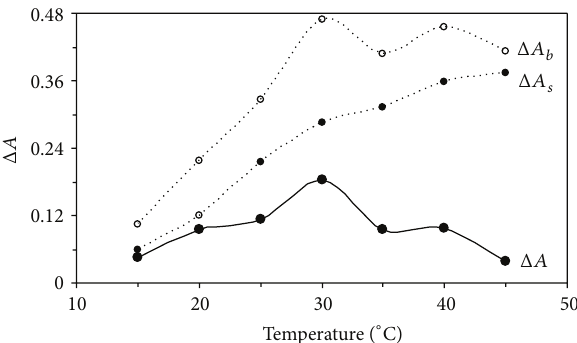
Figure 4: Effect of temperature on the rate of uninhibited ( Δ𝐴 𝑏 ) and inhibited ( Δ𝐴 𝑠 ) reactions and response ( Δ𝐴 ). (Conditions: sulfuric acid, 0.40mmolL −1 ; thionine, 30.0 𝜇 molL −1 ; dopamine, 3.0 𝜇 gmL −1 ; bromate, 0.50 mmolL −1 ; 15–45 ∘ C and 270 s.)